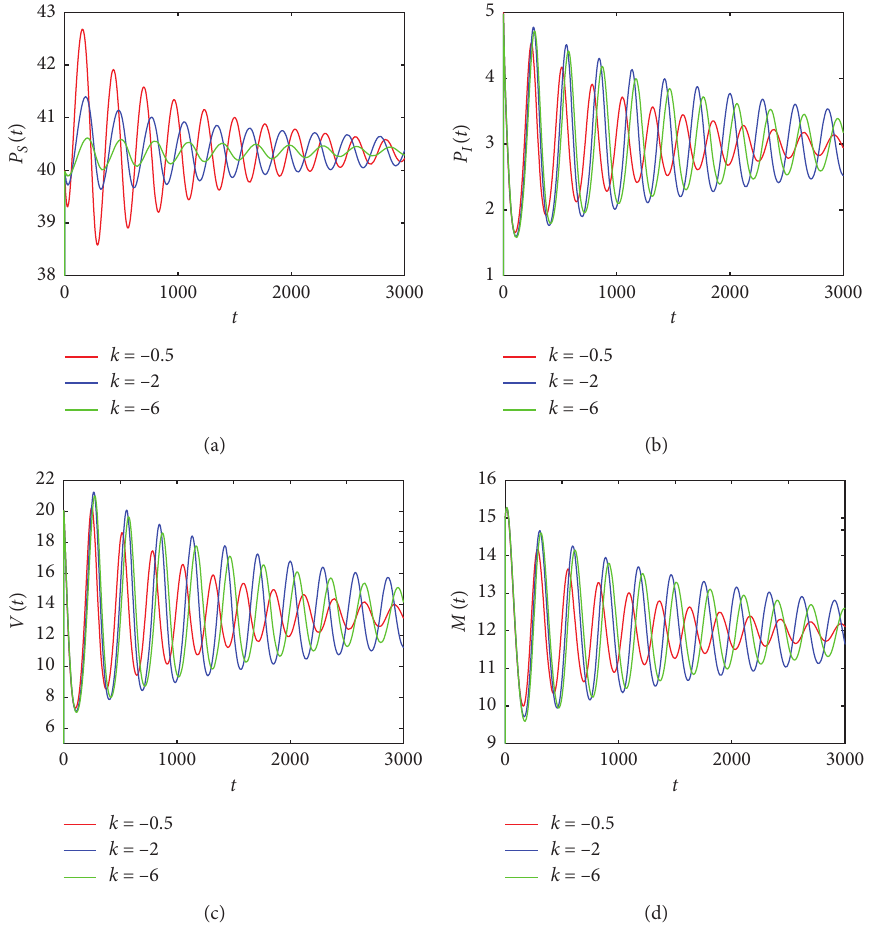
Figure 10: The time series of system (5) when α � 0.95, k � − 0.5, k � − 2, k � − 6, δ � 4 . 8, and τ �